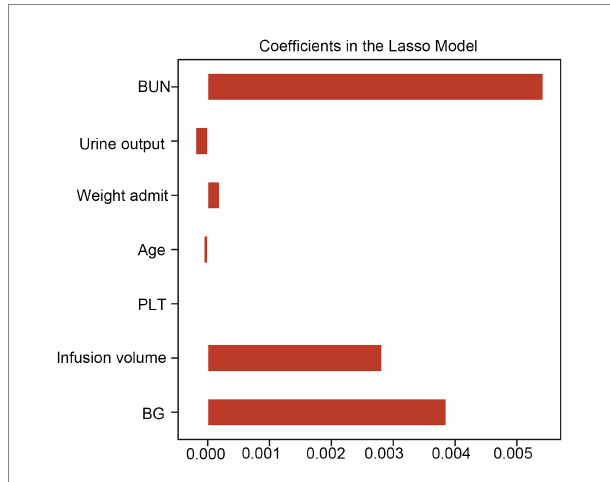
FIGURE 2 Lasso CV method was used to conduct feature selection. LASSO CV, least absolute shrinkage and selection operator cross-validation, BUN, blood urea nitrogen; BG, blood glucose; PLT, platelet